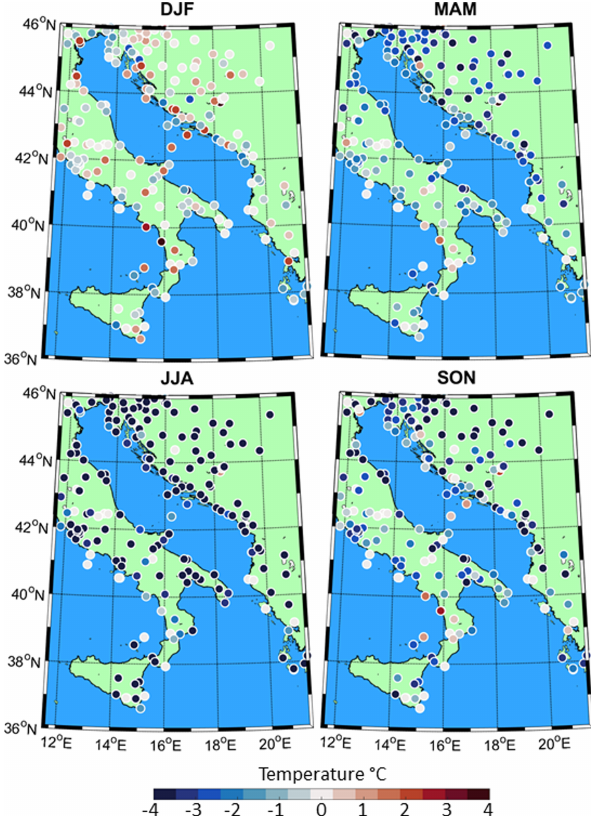
Figure 11. The same as in Fig. 10 but for the hourly dew point